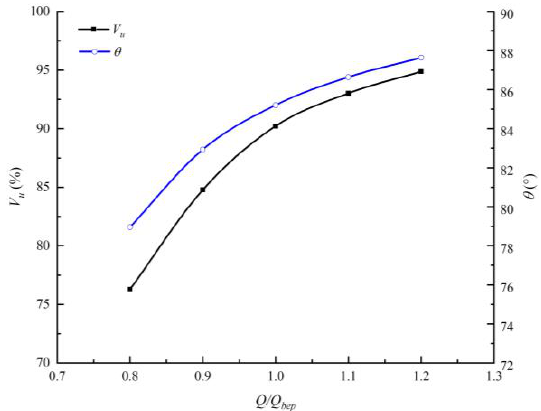
Figure 7. V u and θ of the inlet passage outlet section.